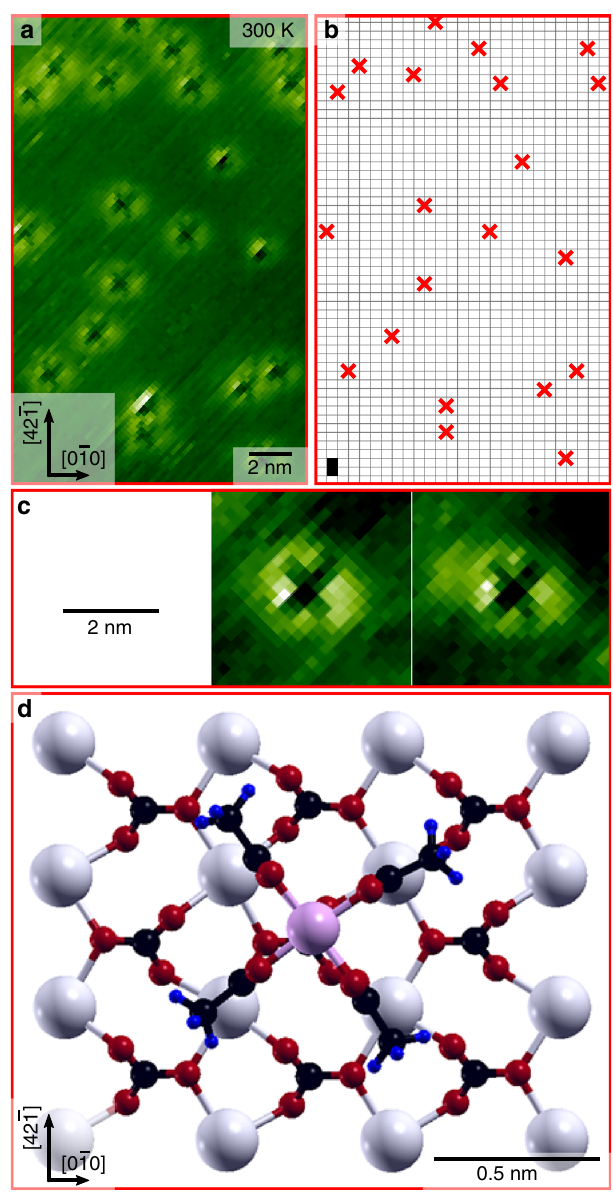
Fig. 3 MoMo adsorption geometry on calcite (10.4). a High-resolution AFM image of MoMo molecules on calcite (10.4) held at room temperature. The molecules are imaged as dark, cross-like structure surrounded by a bright rim. All crosses are oriented in the same direction. b Sketch of the position of the crosses to illustrate the uniform orientation and adsorption site. A calcite (10.4) unit cell is marked with a black rectangle in the bottom left corner. Due to nonlinear thermal drift, a slight deviation between a and b is visible. c Zoom onto two molecules highlighting the cross-like structure. d Top view of thermodynamically most stable MoMo adsorption geometry on calcite (10.4) determined by DFT